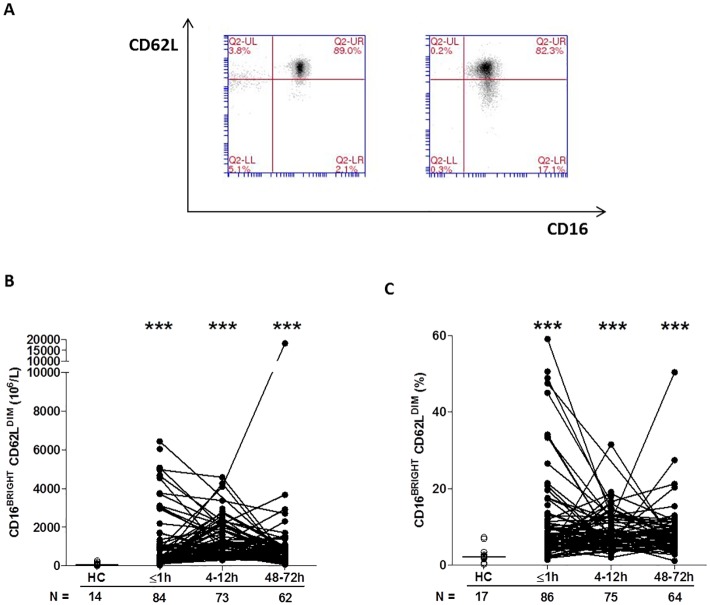
Traumatic injury results in immediate alterations in the composition of the circulating neutrophil pool.(A) Flow cytometry plots depicting the percentage of CD16BRIGHT CD62LDIM neutrophils (lower right quadrant) in blood samples from a single healthy control (left panel) and a trauma patient (right panel). (B–C) Prospective analysis of the absolute number (B) and frequency (C) of circulating CD16BRIGHT CD62LDIM neutrophils post-trauma. The number of samples analysed is indicated below each time point. ***p < 0.0005 versus HCs. The horizontal line for HC data depicts the median value. HC, healthy control.